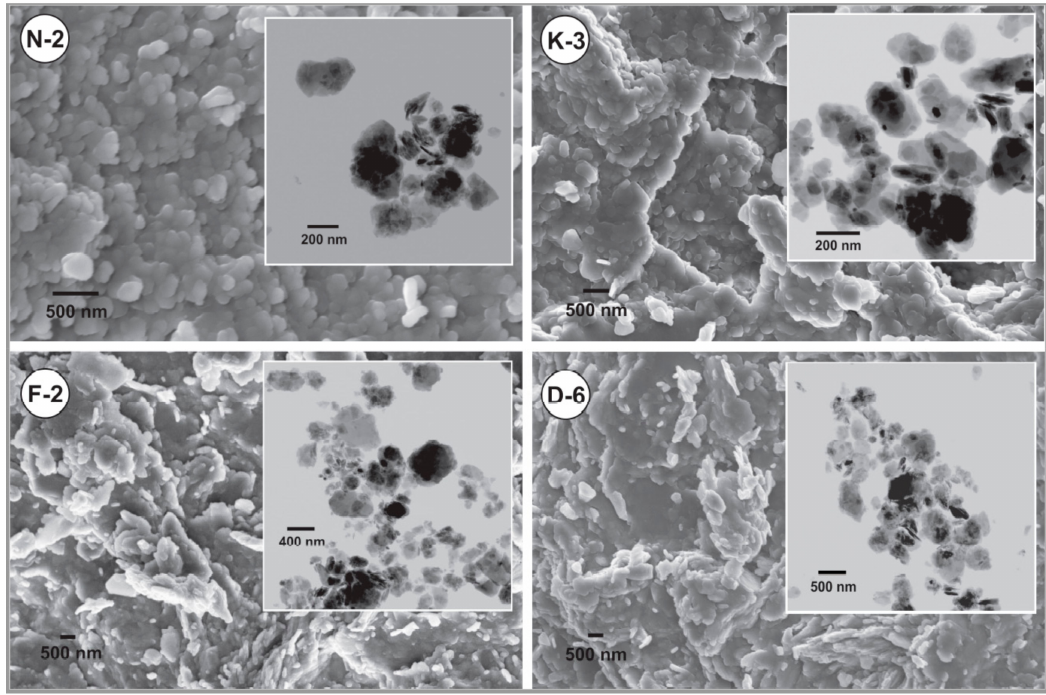
Figure 4. SEM and TEM (upper right views) images showing microtextural characteristics and particles micromorphology of the studied kaolin powder